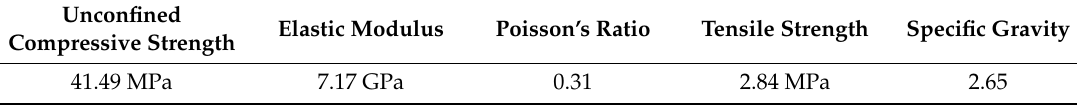
Figure 1. Standard rock tests: ( a ) unconfined compression test; ( b ) splitting test. Table 1. Physical parameters of gypsum